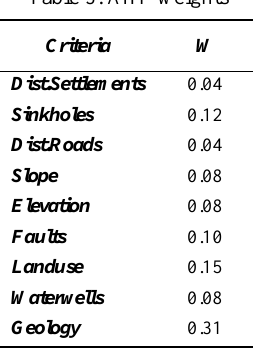
Table 3. AHP weights